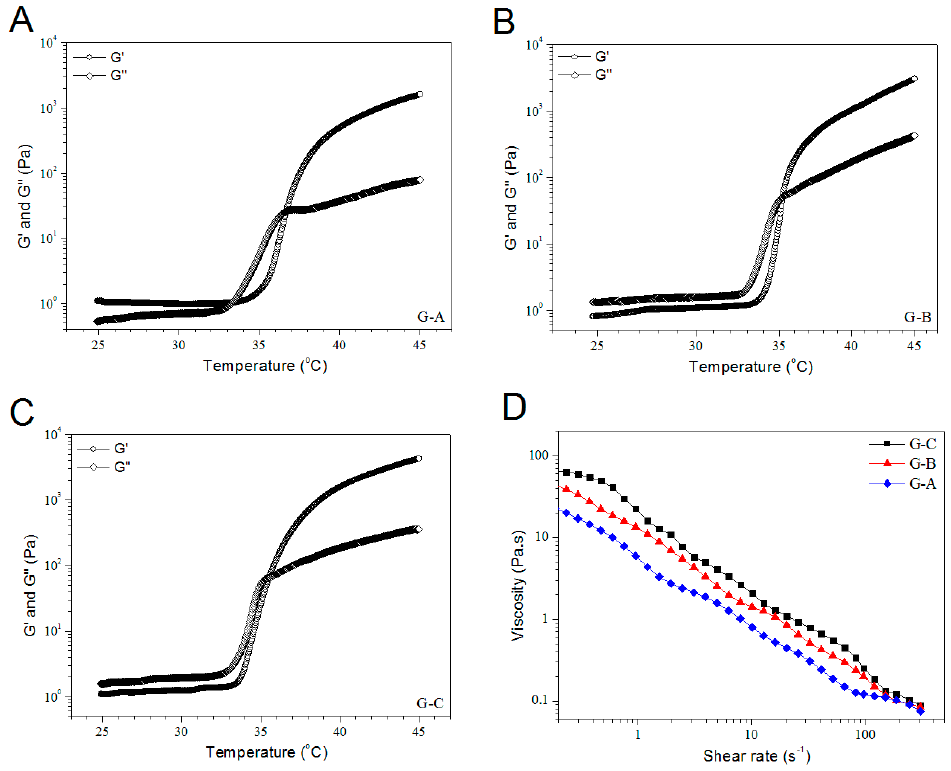
Figure 4. Temperature sweep curves ( A , B , and C ) and shear viscosity ( D , 23 ° C) for BG/ALG–POL/SF gels.